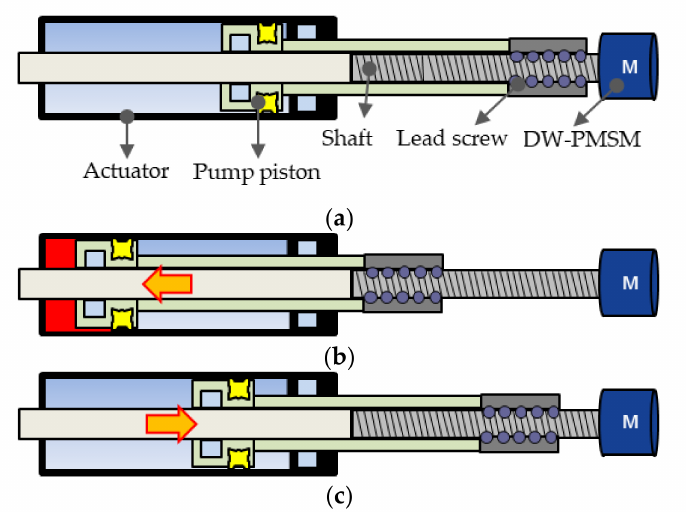
Figure 3. Pump piston movement in the actuator according to motor driving: ( a ) initial actuator configuration of the EHB system; ( b ) brake pressure application with pump piston advancement; ( c ) brake pressure release with retraction of the pump